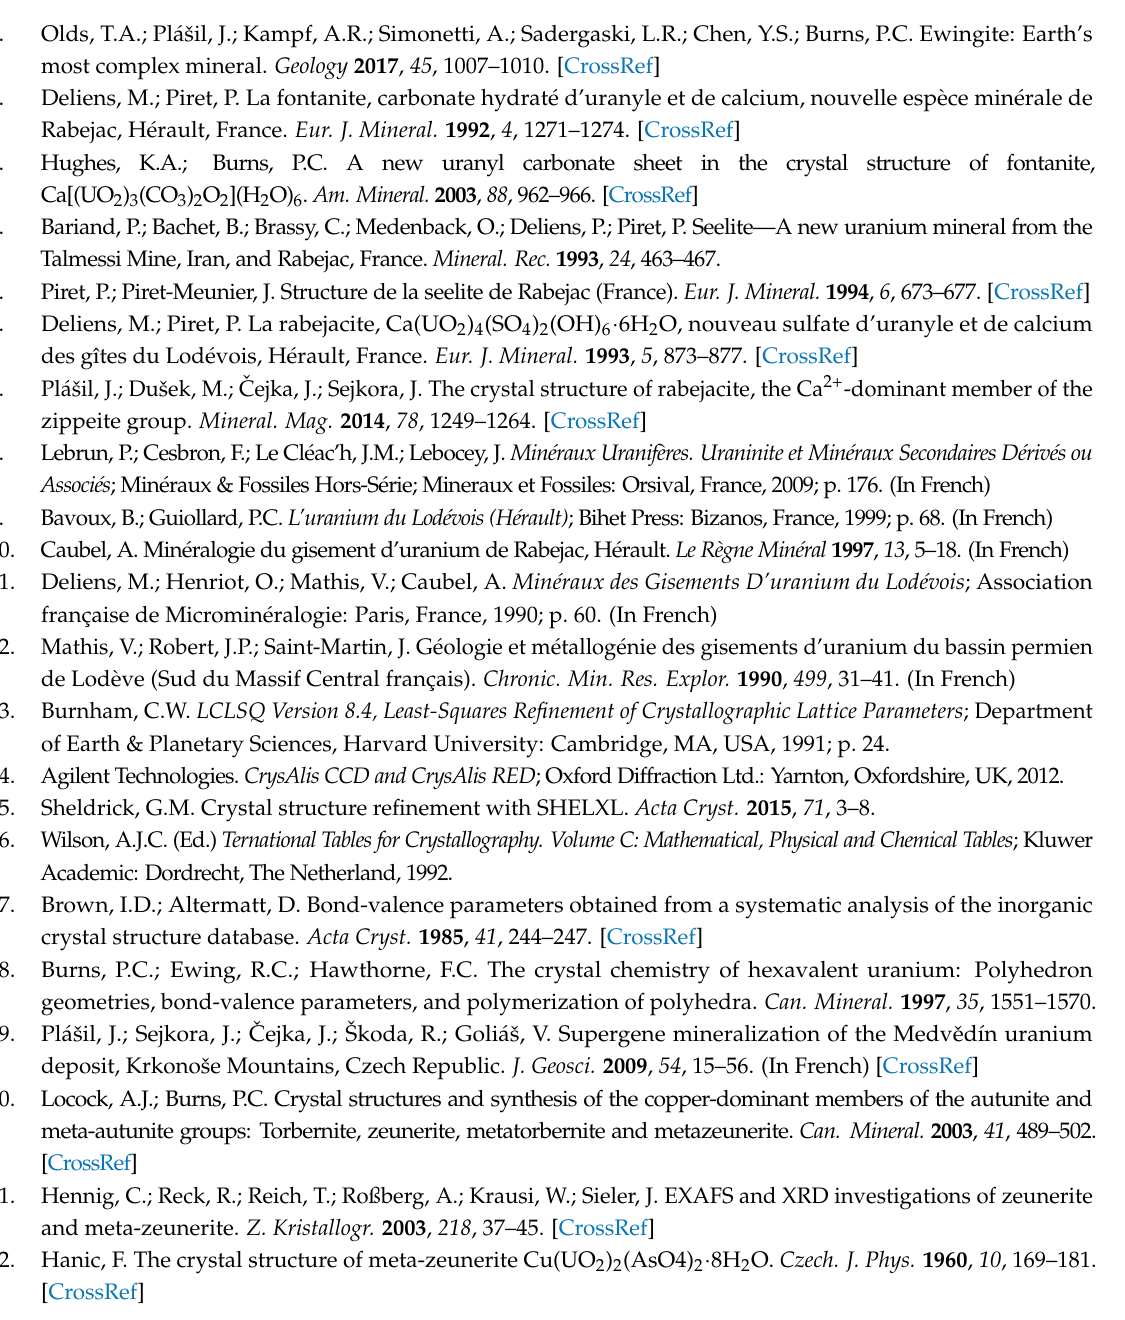
Table S13: Bond-valence table ( vu ) for liebigite from Rabejac,